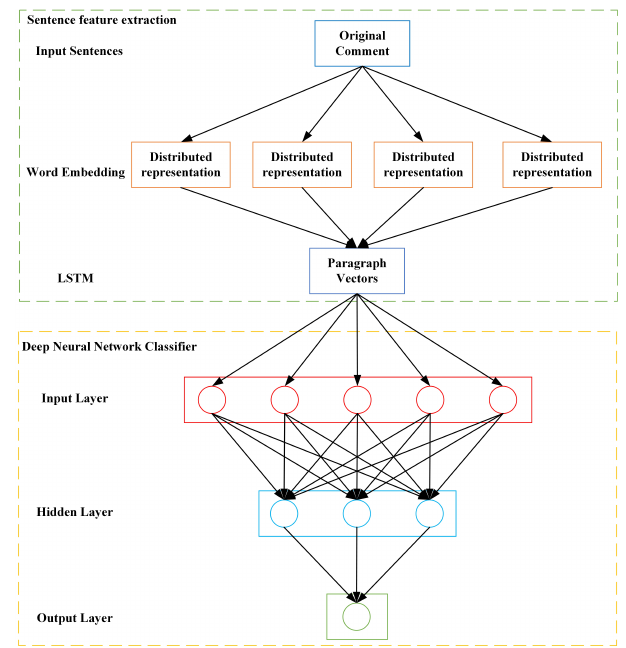
Figure 3. The architecture of the sentiments analysis model.